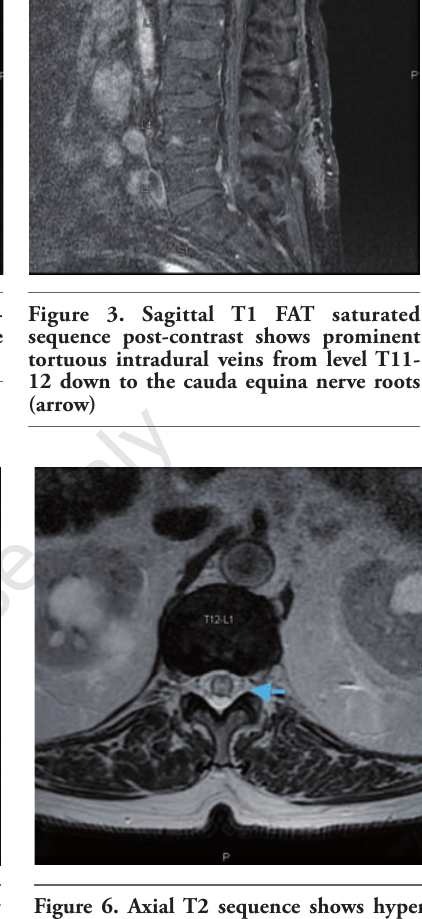
Figure 4. Axial T1 FAT saturated post con- trast image shows enhancement of promi- nent intradural veins (arrow).